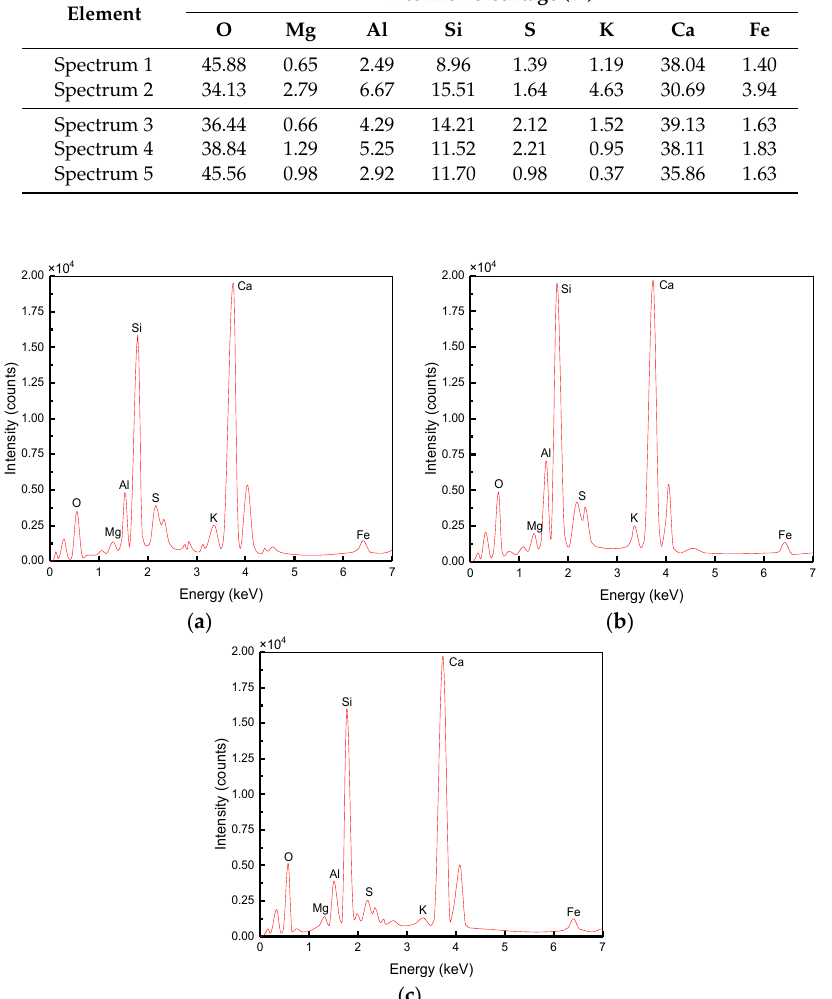
Figure 24. Energy spectrum in di ff erent areas of PC: ( a ) Spectrum1: Energy spectrum in the ITZ; ( b ) Spectrum2: Energy spectrum at 500 μ m away. Table 8. The atomic percentage of di ff erent energy spectrums. Element